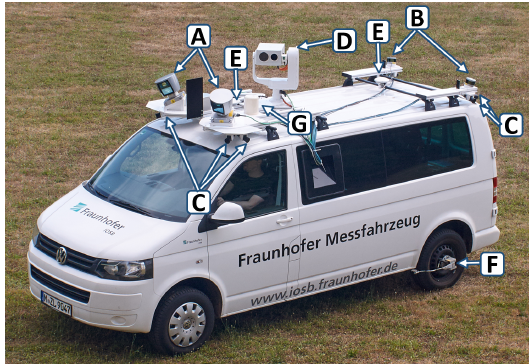
Figure 1. The external components of the sensor system MODISSA A: 2x Velodyne HDL-64E LiDAR B: 2x Velodyne VLP-16 LiDAR C: Panoramic camera setup 8x Baumer VLG-20C.I. 2